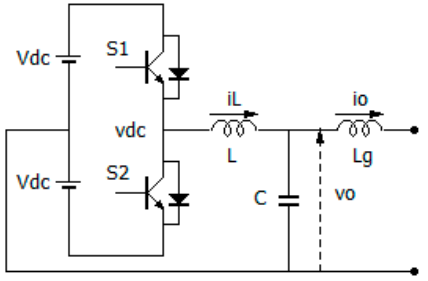
Figure 3. Single-phase half-bridge inverter circuit. Energies 2018 , 11 , x FOR PEER REVIEW